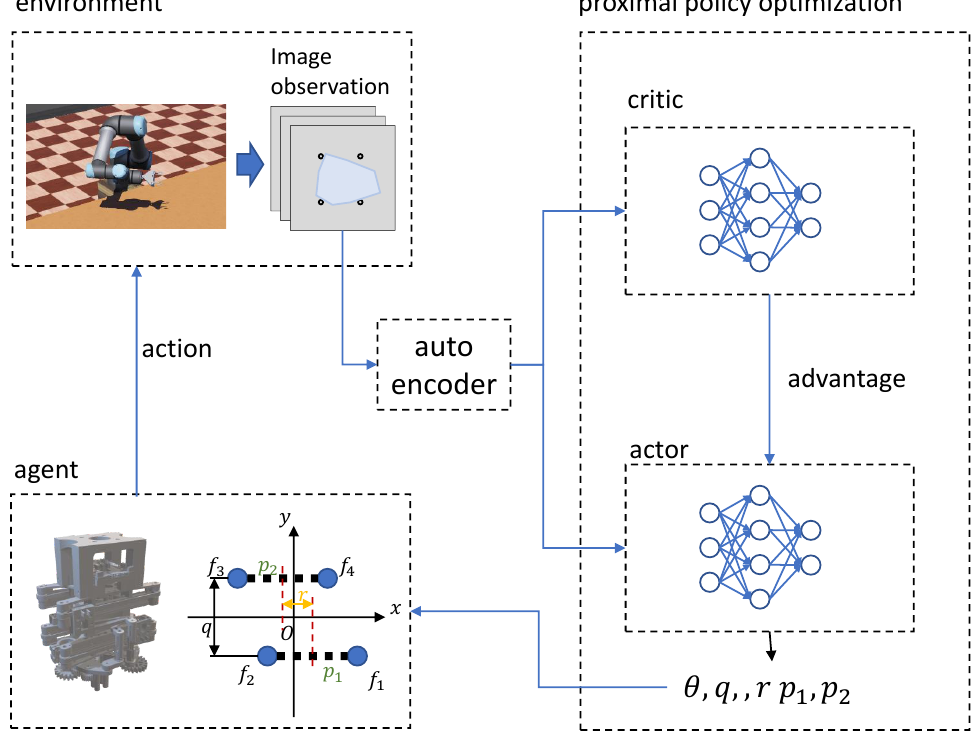
Figure 2. Full pipeline for training the four-pin gripper for form